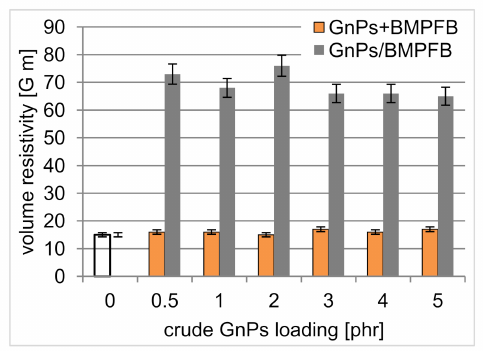
Figure 7. Dependence of SBR composites volume resistivity ( ρ ) on pristine GnPs loading.